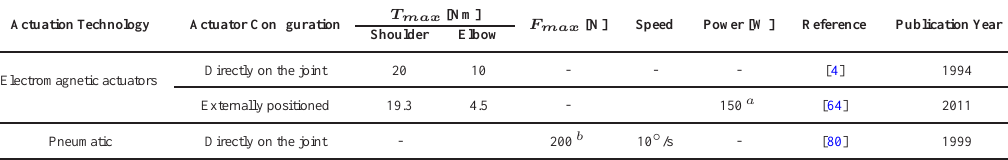
Table 3. Overview of the maximum torque/force of the IAS